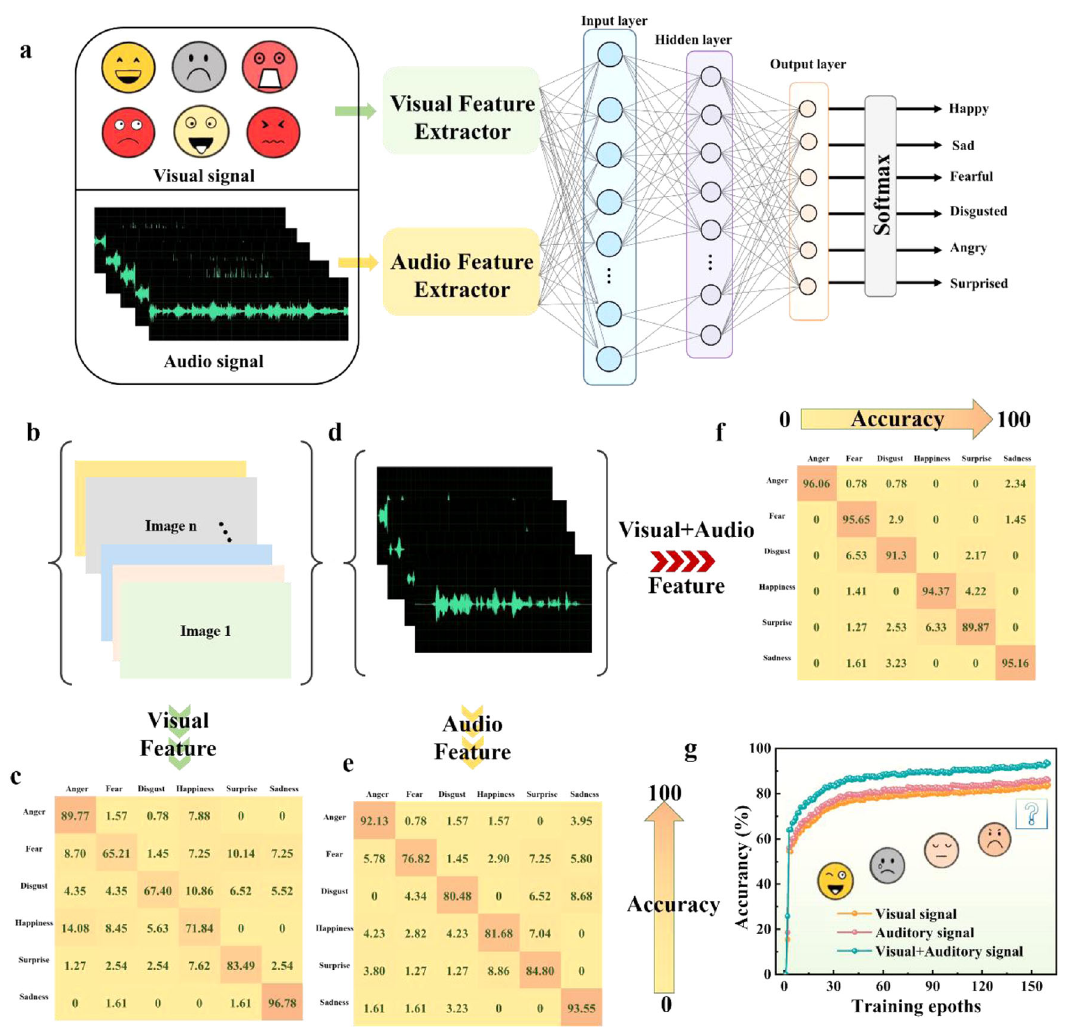
Fig. 6 | Multi-model emotion recognition system. a The schematic diagram of multi-model emotion recognition system to recognize the six emotions (anger, fear, disgust, happiness, surprise, and sadness), where the recognition process includes information fusion, feature extract, data classi fi cation, emotion recogni- tion. b The pictures extract from database without sound information for emotion recognition. c The recognition accuracy of different emotion with single visual